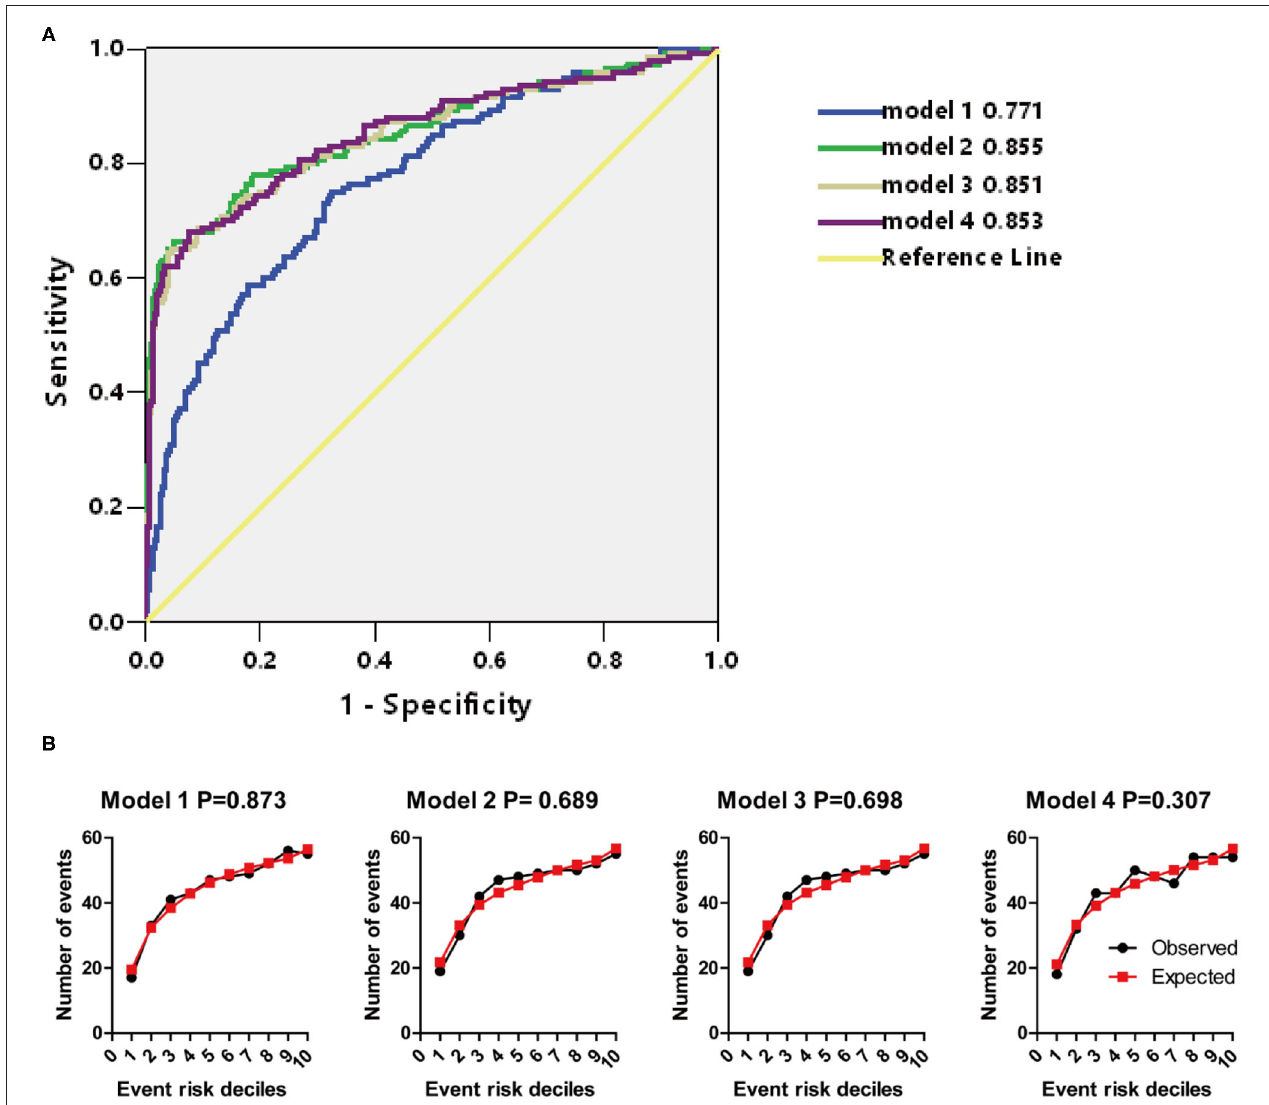
FIGURE 6 | (A) AUCs of models 1–4. (B) Hosmer–Lemeshow (H–L) test of models 1–4.